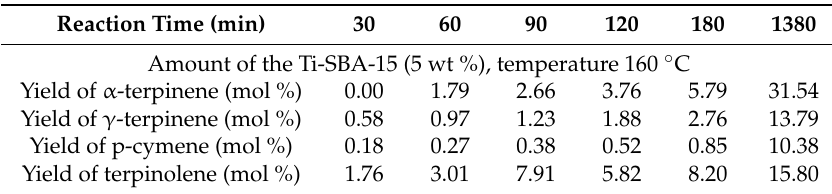
Table 2. The influence of reaction time, temperature, and catalyst content on the yield of main products of isomerization of